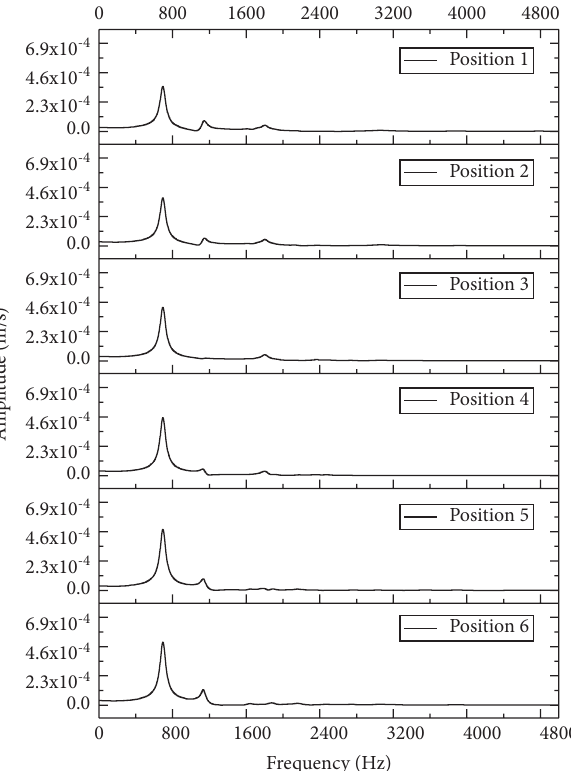
Figure 14: Waveform spectrogram of dense region. Figure 13: Waveform spectrum diagram of defect